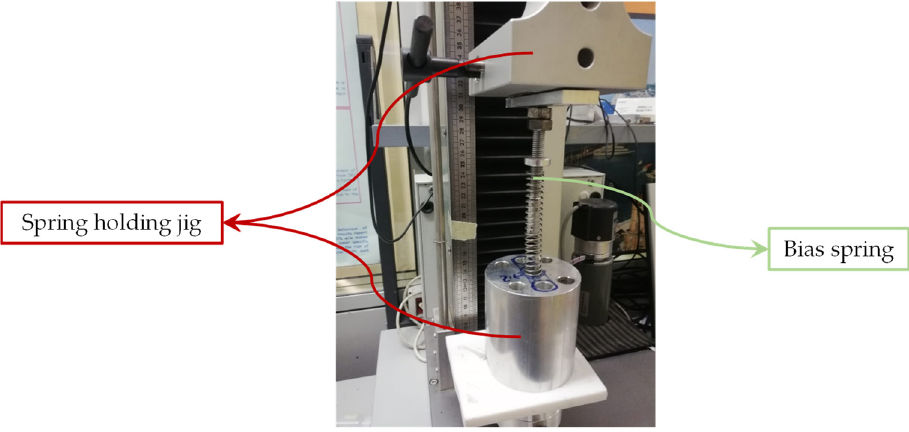
Figure 5. Bias spring during compression test.